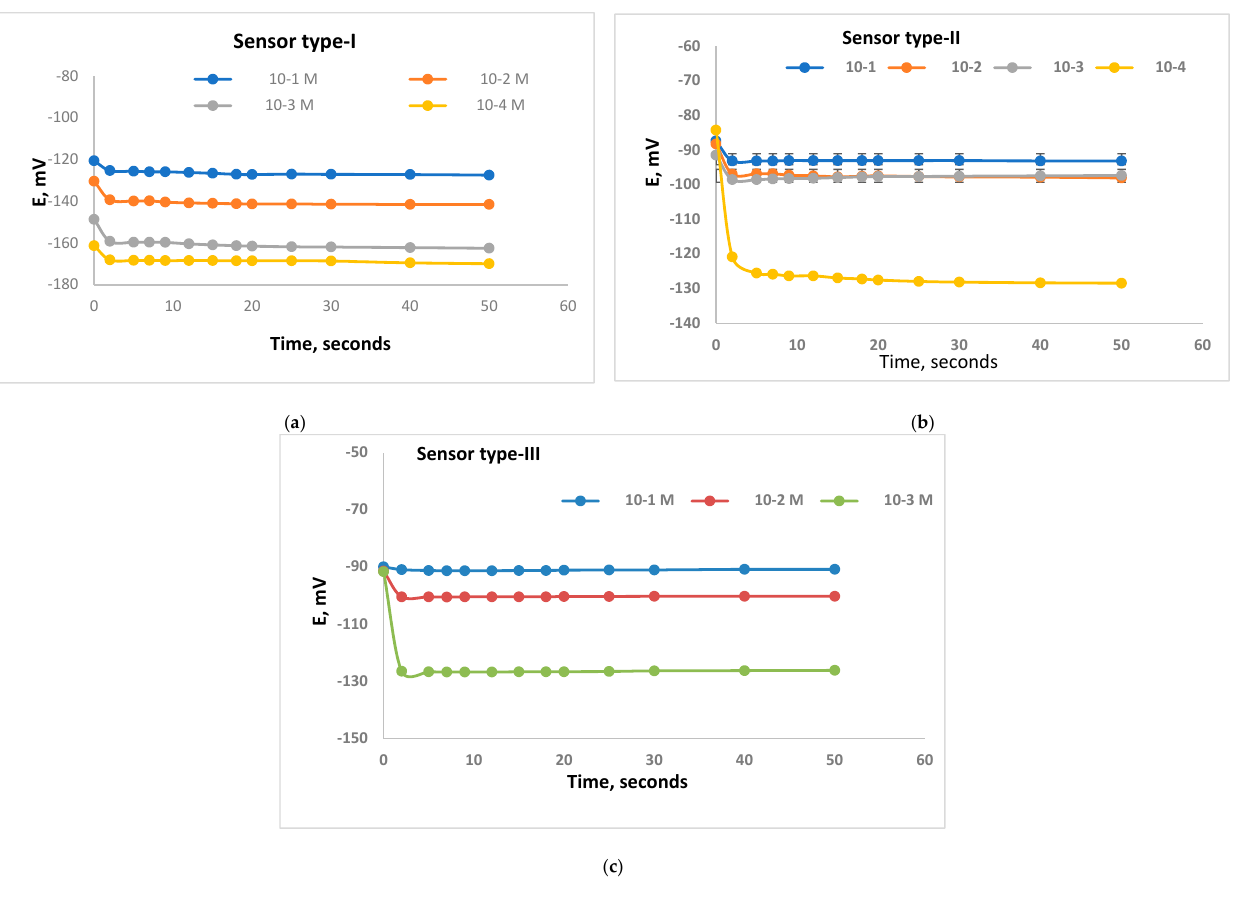
Figure 3. Dynamic response for Ca-selective electrodes with membrane type I ( a ), type II ( b ),